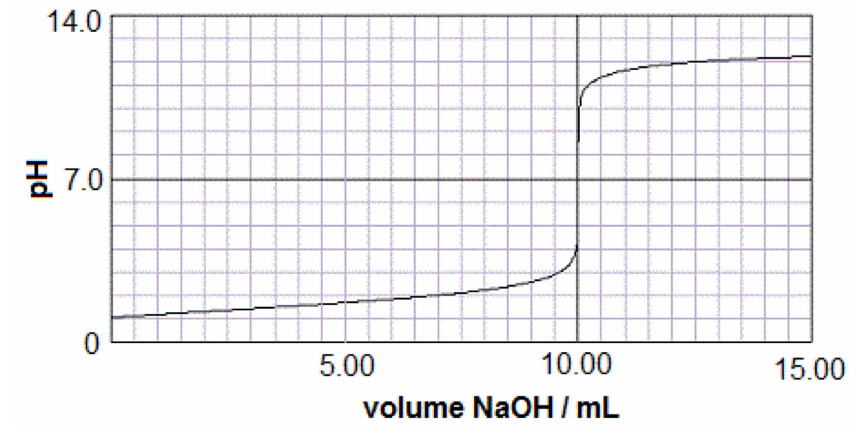
Figure 3. Typical titration graph of 5 mL 100 millimolal H 2 SO 4 with 100 millimolal